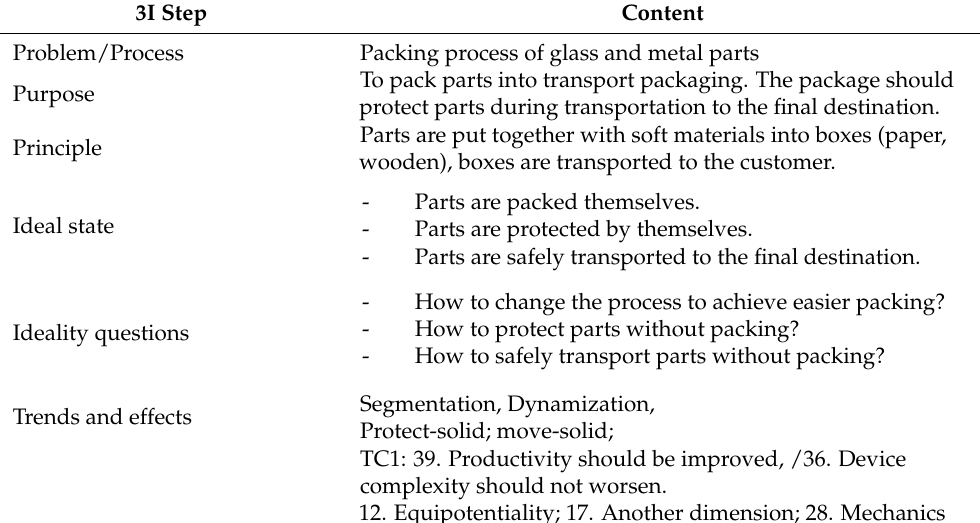
Table 2. An application of the 3I method to the whole packing